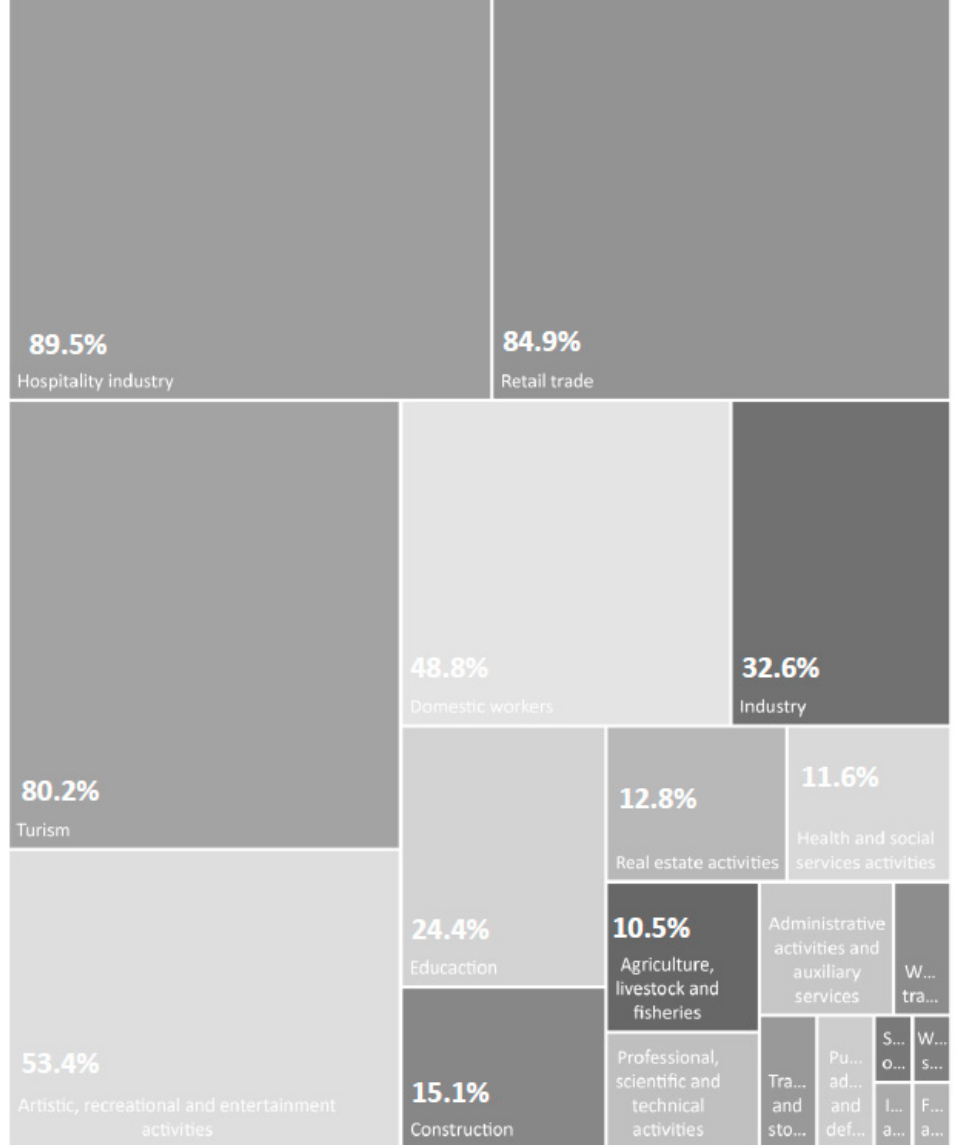
Figure 3. Sectors of activity that are currently the most affected according to the entities’ selection in terms of the total responses received.